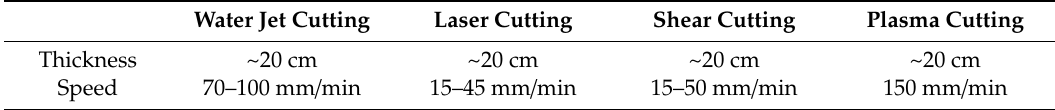
Table 2. Thickness and speed of main cutting